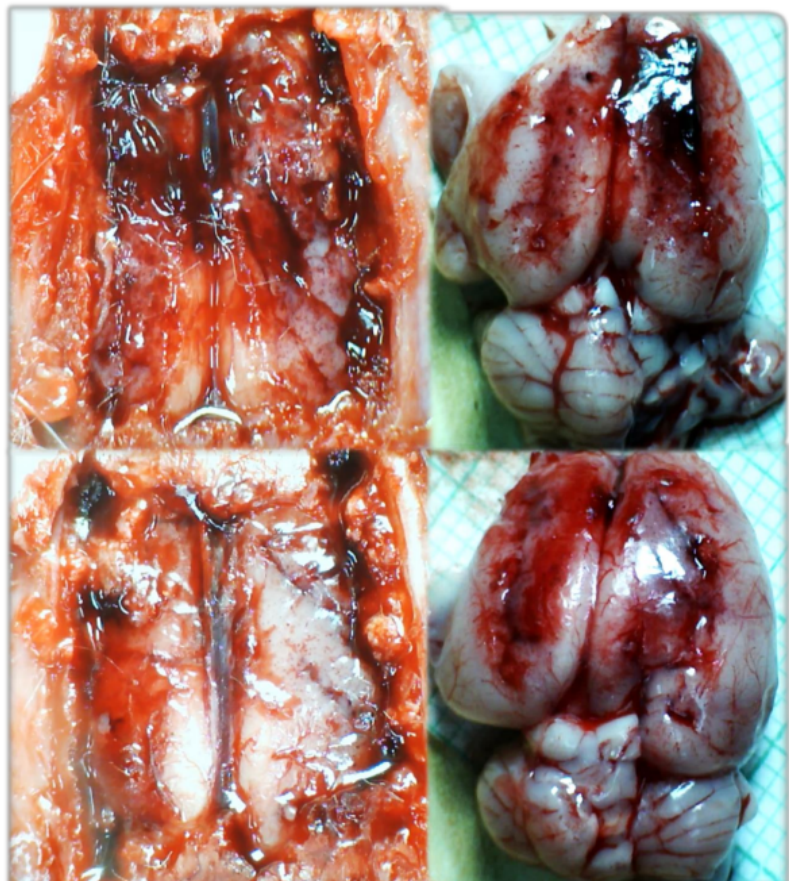
Figure 9. Illustrative brain presentation in the rats with the occluded superior mesenteric vein and artery, in the calvarial window immediately after vessels occlusion, and subsequent medication saline (5 mL/kg ip) (low, control) or BPC 157 (10 ng/kg ip) (upper)) (left) and after sacrifice (right), at the 30 min ligation-time. Saline (5 mL/kg ip) (low, control) or BPC 157 (10 ng/kg ip) (upper). Prominent brain swelling in control rats (low), completely reversed in BPC 157 rats (upper).